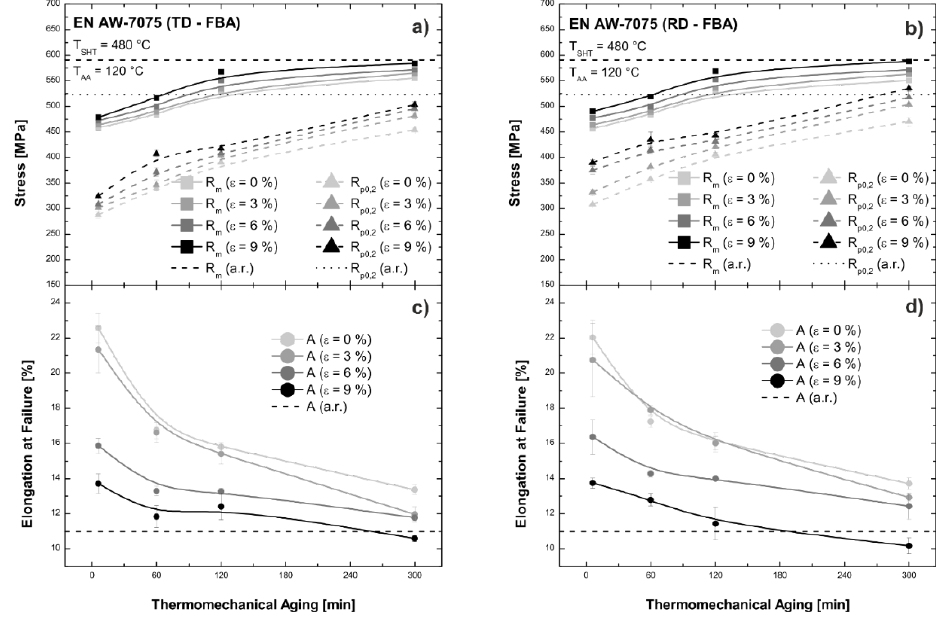
Figure 4. Influence of aging duration and strain on mechanical properties of AA7075 for thermo- mechanical aging strategy “Forming before Aging” ( a , c ) transverse and ( b , d ) parallel to the rolling direction. All specimens are taken from the thermo-mechanically aged conditions and are tested at room temperature.